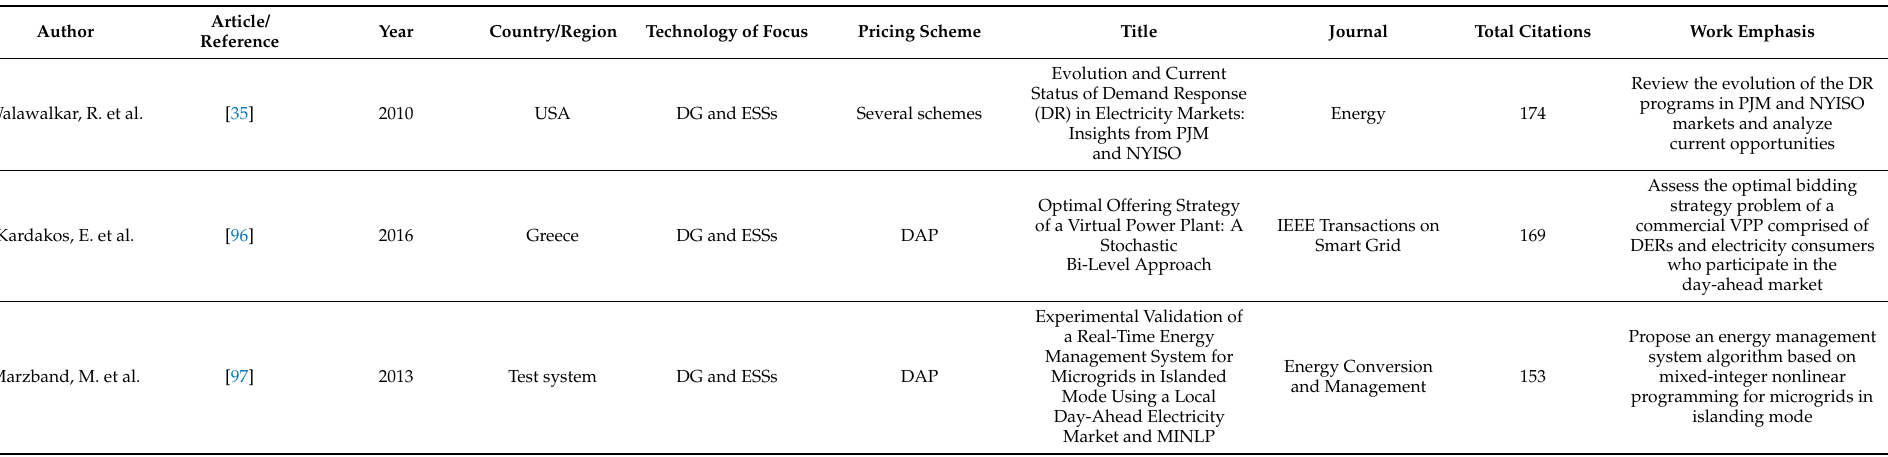
Table A4. Most-cited articles from Sample 2. Source: own study using data from